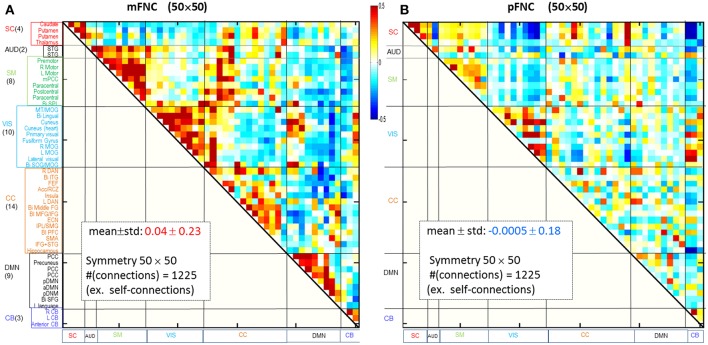
Brain resting-state subfunction arrangement and functional network connectivity. (A) Magnitude data depiction: a set of 50 mICA components are classified into seven (7) brain domains {SC(4), AUD(2), MOT(8), VIS(10), CC(14), DMN(9), and CB(3)} and the mFNC matrix (mean ± std: 0.04 ± 0.23); (B) Phase data depiction: the pICA components are classified into 7 domains and the pFNC matrix (mean ± std: −0.0005 ± 0.18).